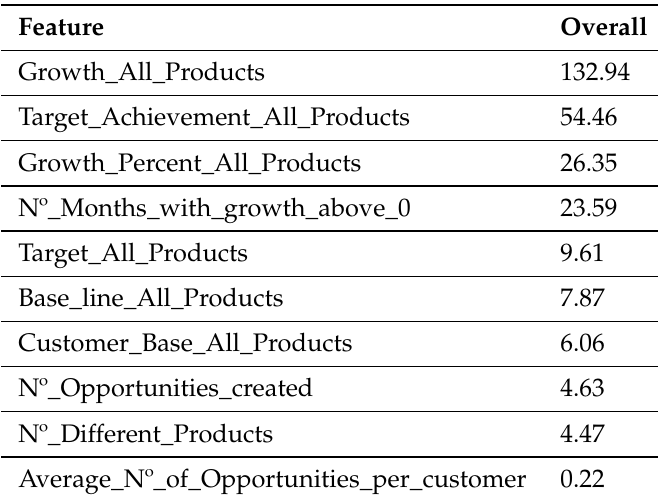
Table 7. Feature importance.